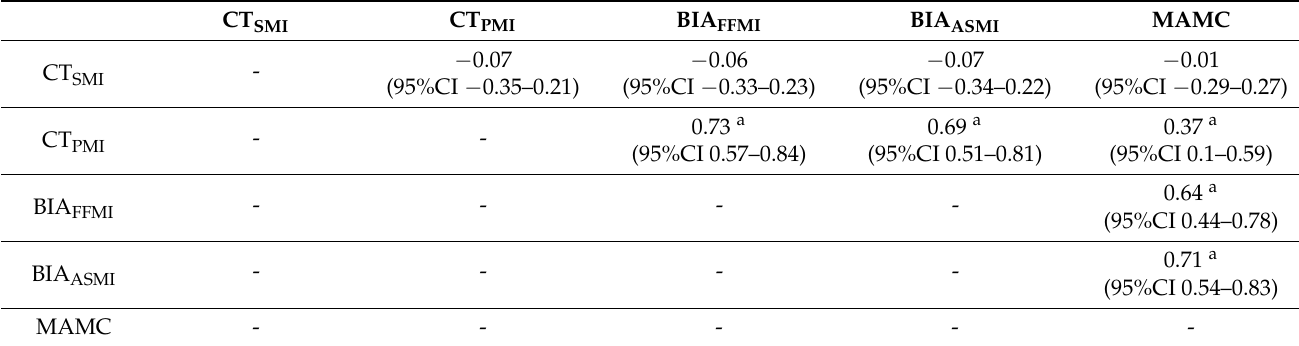
Table 3. Intraclass correlations for the concordance based on z-scores between muscle mass measures.